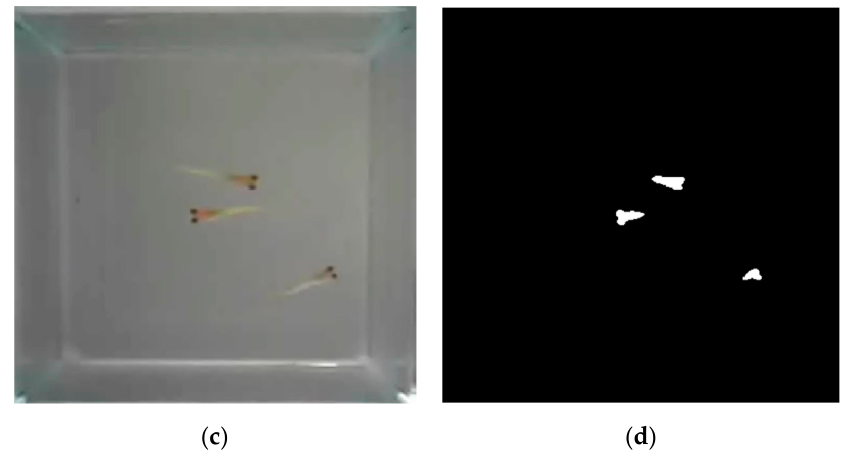
Figure 6. ( a ) Video before background subtraction; ( b ) Result after background subtraction with negative effect; ( c ) Video before image segmentation; ( d ) Result after image segmentation.